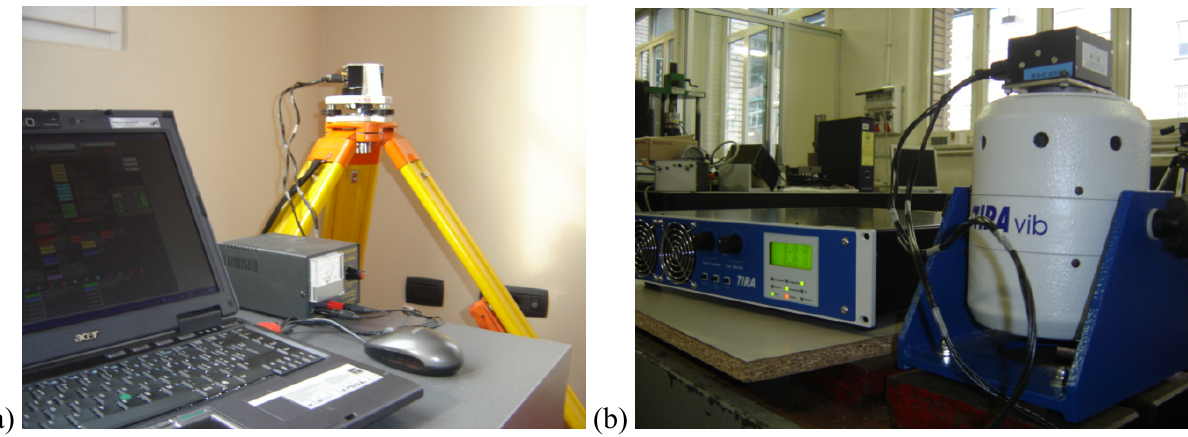
Figure 5. Experimental settings: (a) evaluation of static systematic and accidental errors by means of the six positions static test and the Allan variance calculation; (b) dynamic excitation step of the reliability test